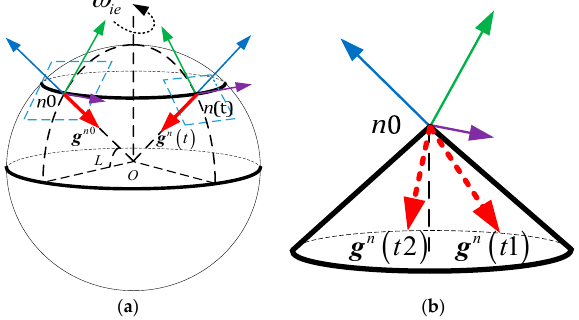
Figure 2. ( a ) The n -frame motion due to the self-rotation of the earth; ( b ) the apparent gravitational motion in the n 0-frame.